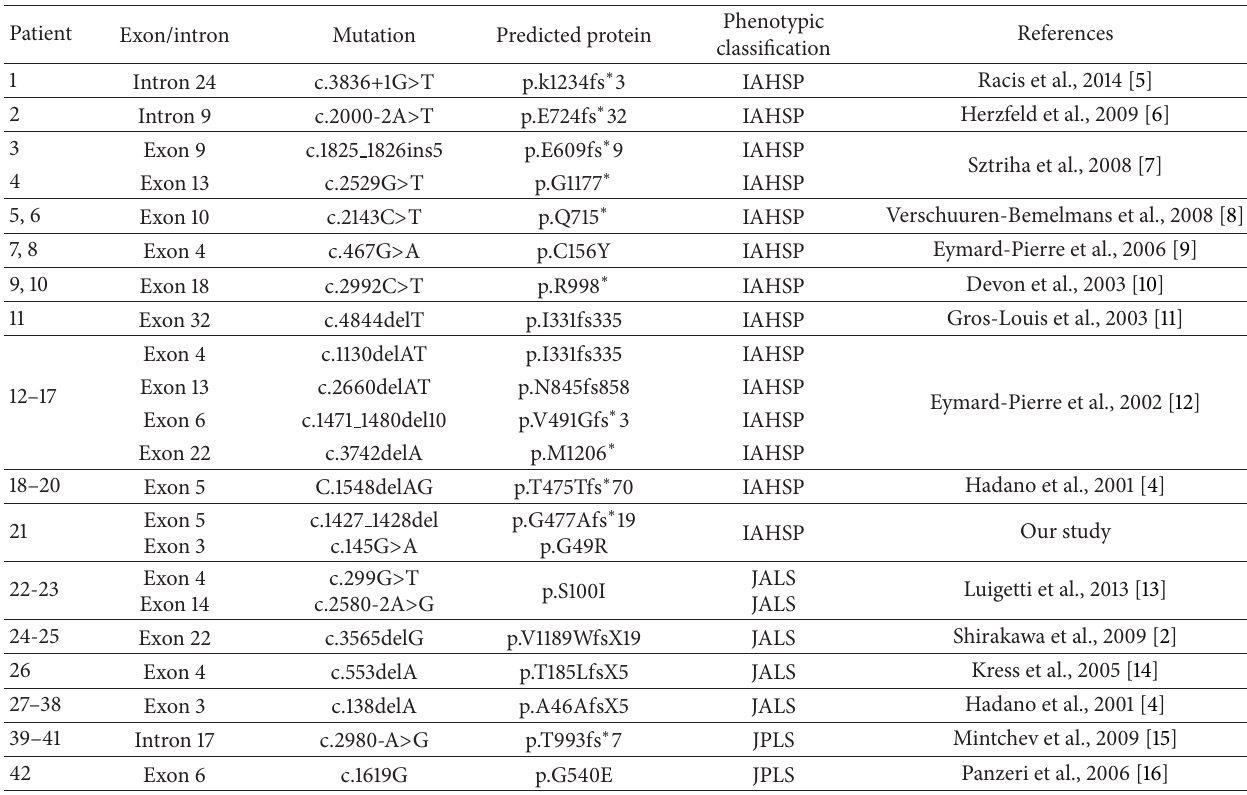
Table 1: Mutations in ALS2 related